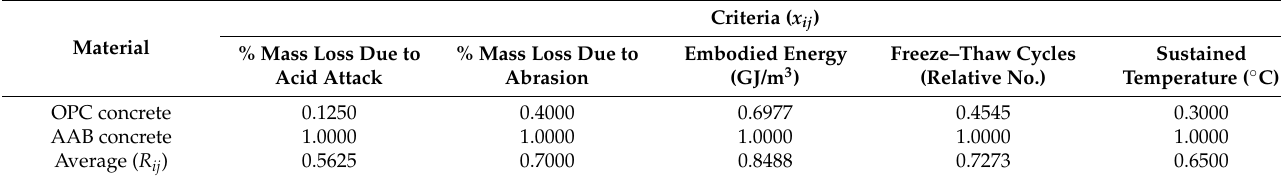
Table 4. Normalized R ij data of material selection attributes.